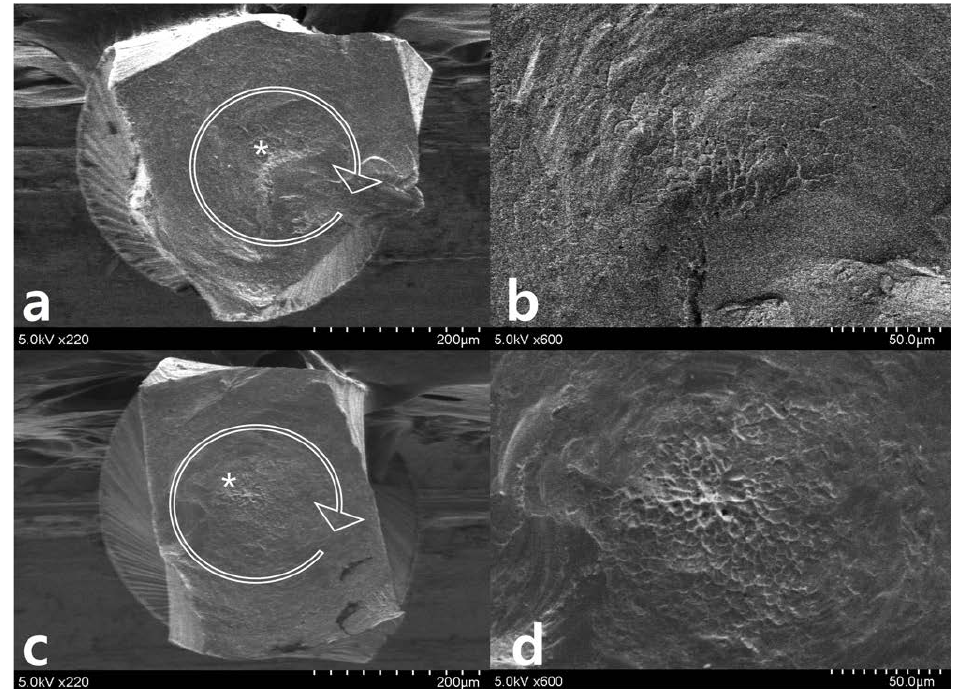
Figure 6. Scanning electron microscopy images of the fractured cross-sectional surfaces after single continuous rotation test, ( a , b ) WO and ( c , d ) WOG. The cross-sectional images revealed typical features of torsional fractures, concentric abrasion marks ( circle arrows in ( a , c )), and fibrous dimples from the torsional center ( b , d ).